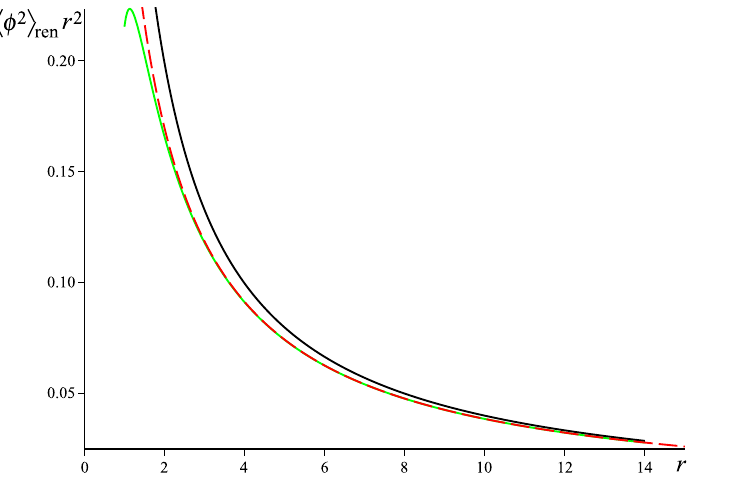
Figure 2. Plots of (cid:104) φ 2 (cid:105) ren (times r 2 ) for α = 0.1: computed exactly (by Equation(39), red dashed curve), for the main asymptotic term ( k max = 0, by Equation(41), black curve) and for k max = 3 (in Equation(40),